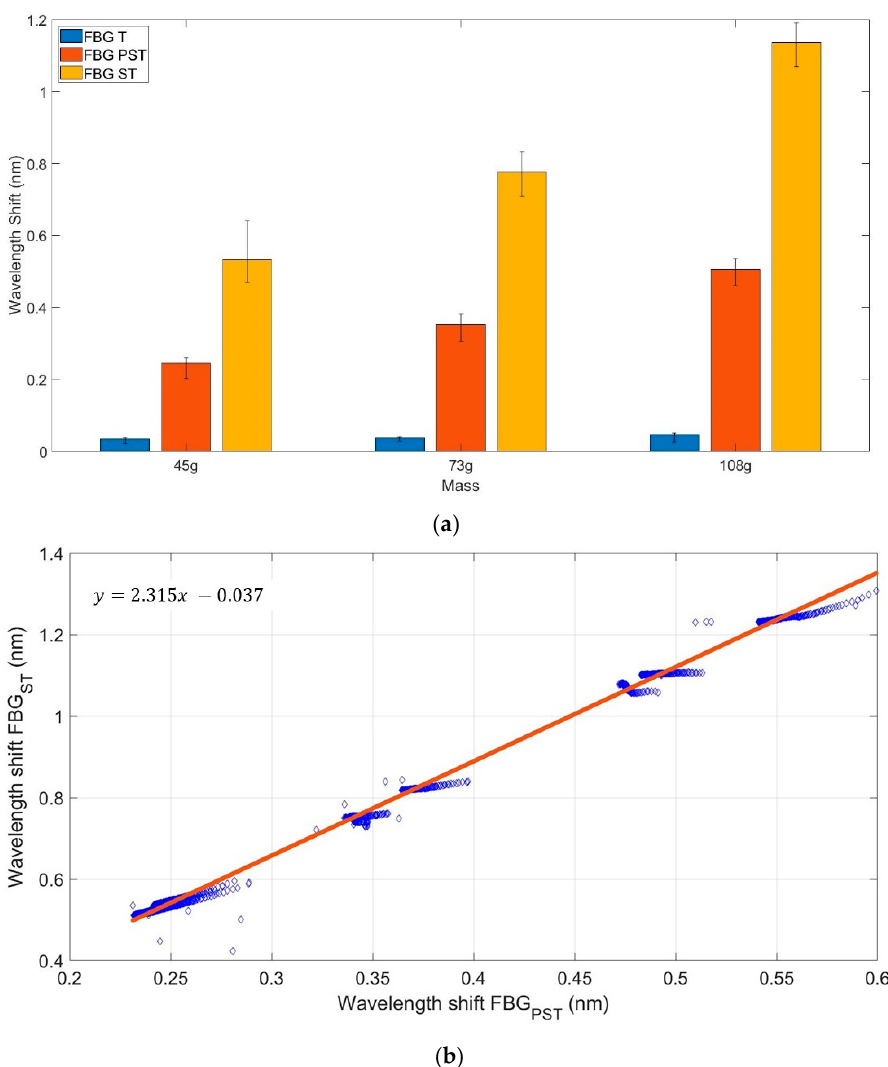
Figure 8. ( a ) Typical response of the 3 FBGs to the load applied for strain compensation measurements (using experimental set up in Figure 3), showing the mean wavelength shift for each applied mass. ( b ) Typical results showing the relative wavelength shift in response to strain from the FBG PST encapsulated with polymer and FBG ST in the bare fibre. Although only three different masses were used, the sampling rate of the sensor compared to the settling time of the scales means a range of wavelengths were recorded for each mass.